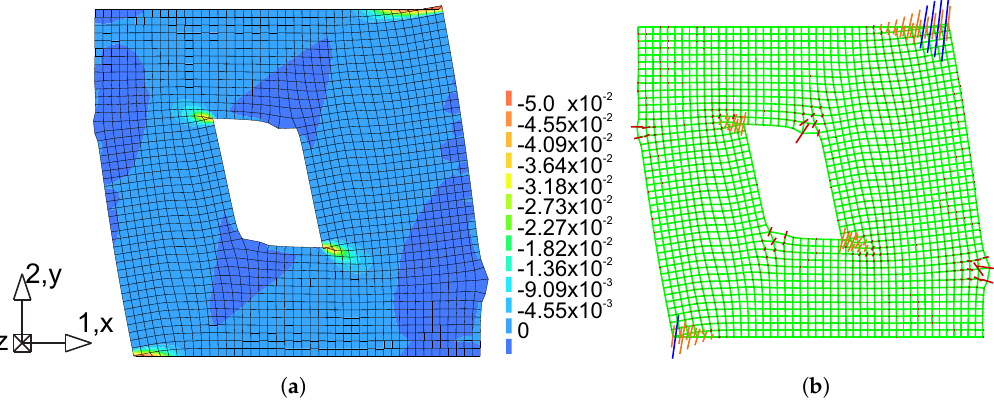
Figure 17. Maps of minimum principal plastic strain at ∆ = 12 mm: ( a ) compressive failure zones, ( b ) directions of the compressive